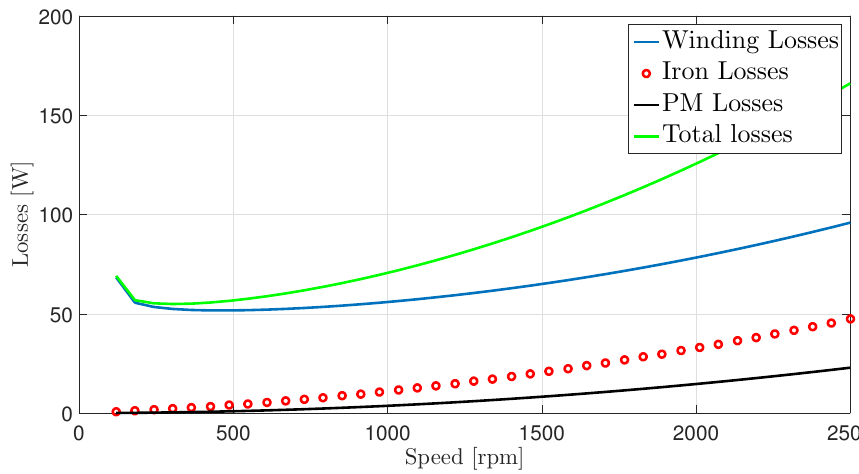
Figure 12. The winding, core, PMs and total loss variation with the speed.